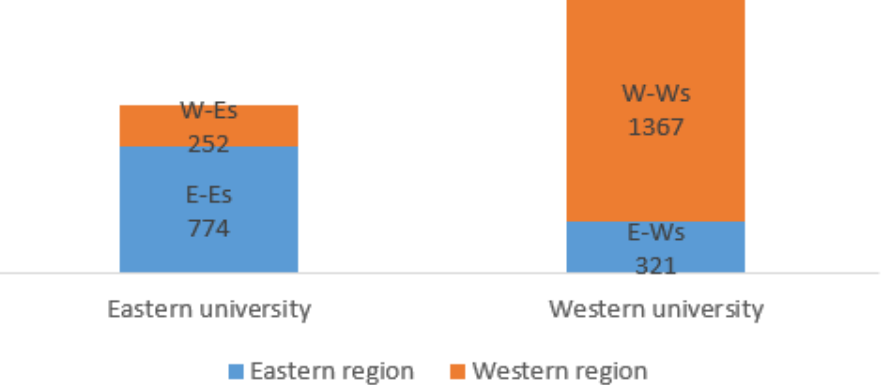
Figure 1. The grouping of university students for the present study. Note: E-Es: Eastern local students; W-Ws: Western local students; E-Ws: Eastern–western migrant students; W-Es: Western–eastern migrant students.